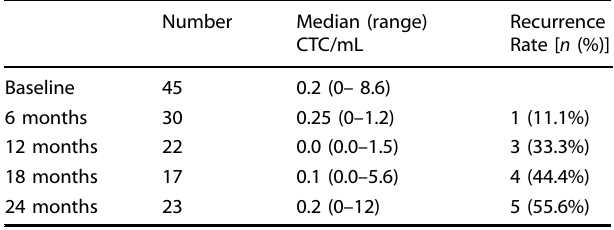
Table 3. Change in CTCs over